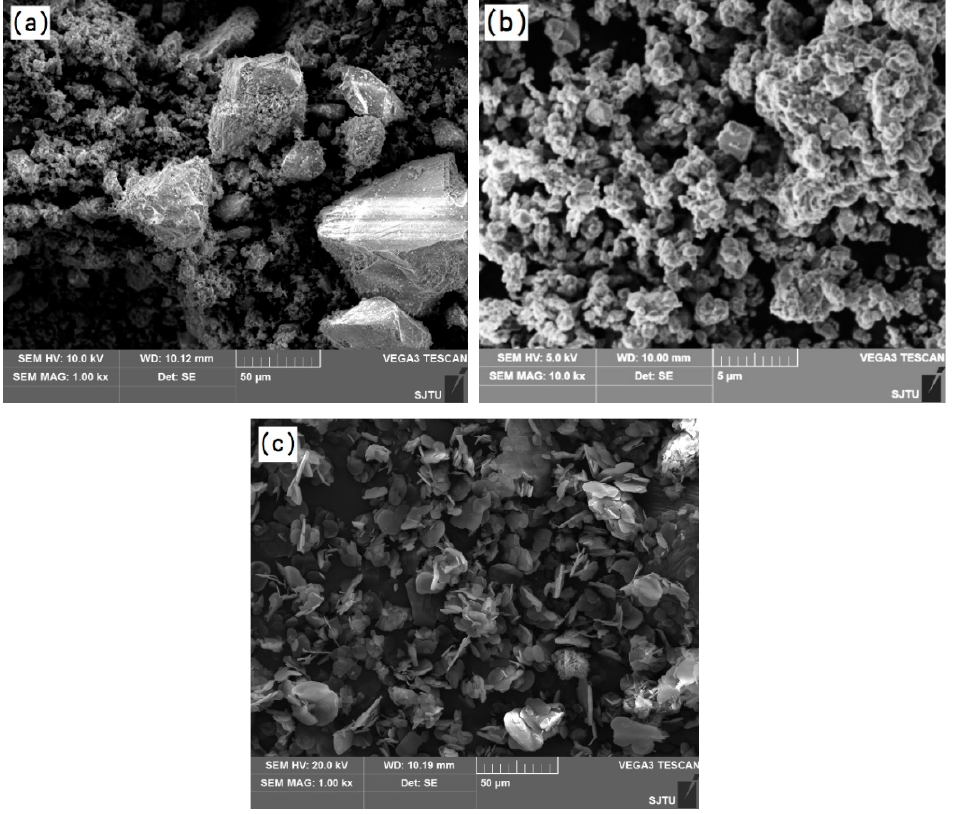
Figure 4. Particle morphology of the refractory powders: ( a ) fused alumina, ( b ) chromium oxide and ( c ) hexagonal boron nitride.